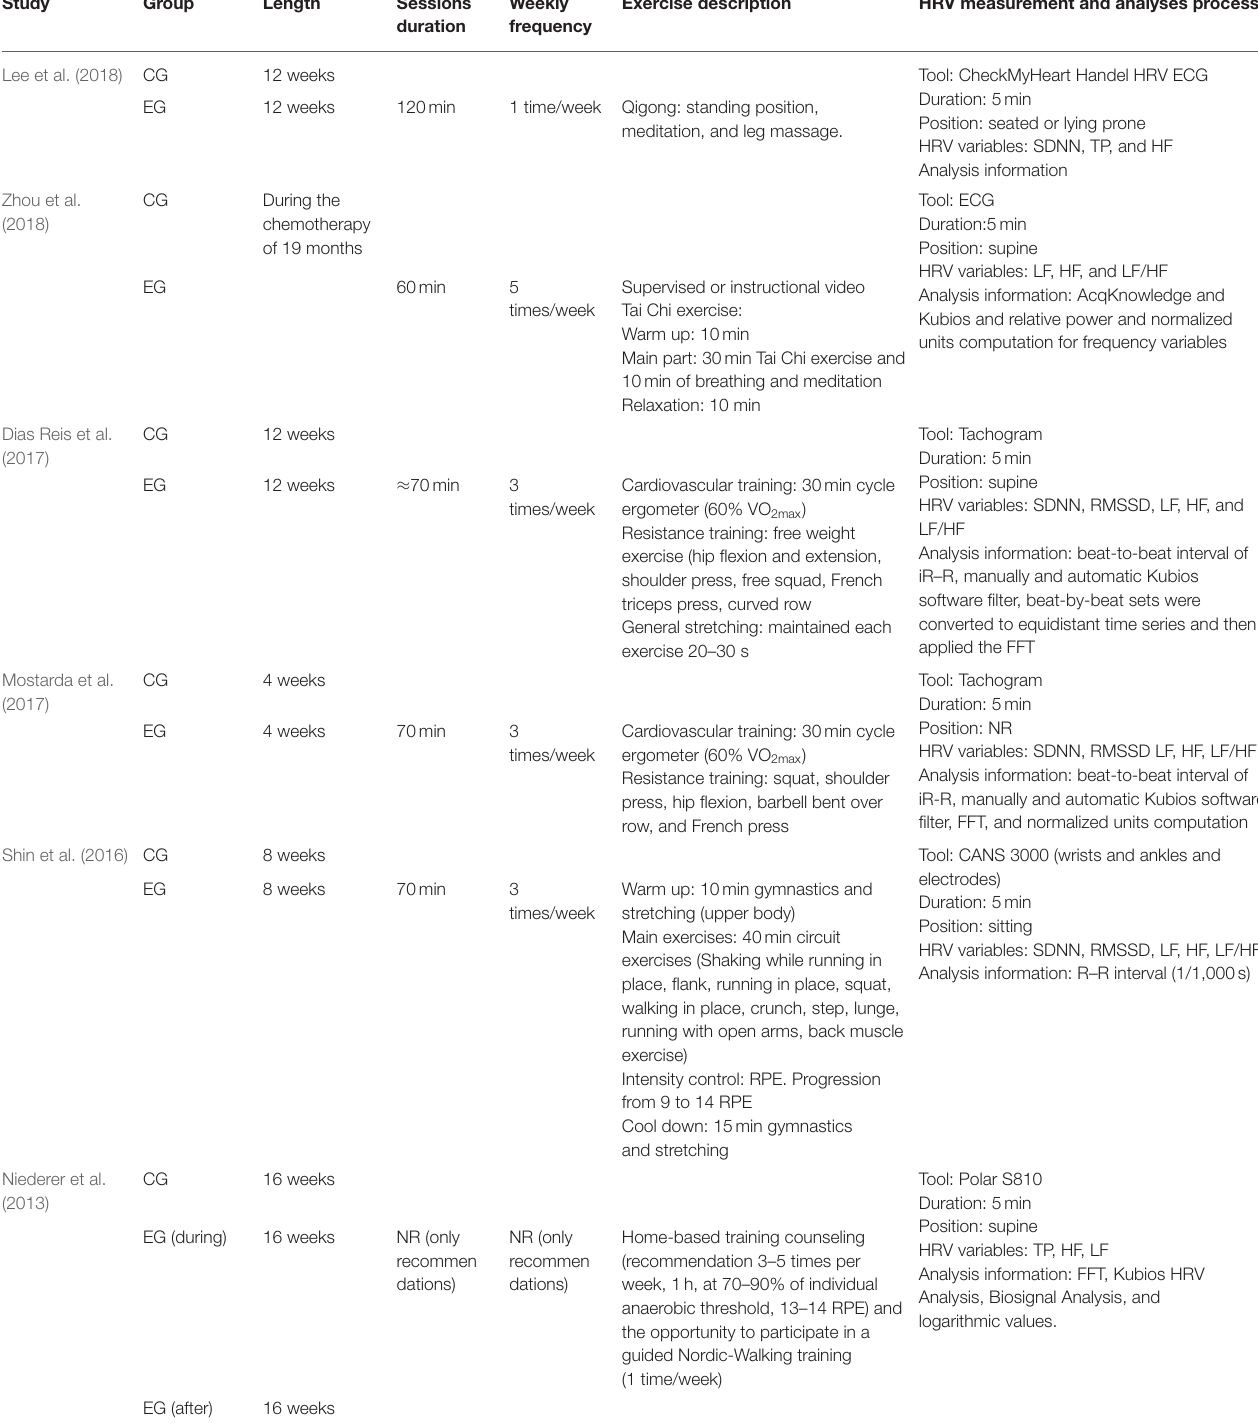
TABLE 3 | Characteristics of exercise interventions and heart rate variability (HRV)